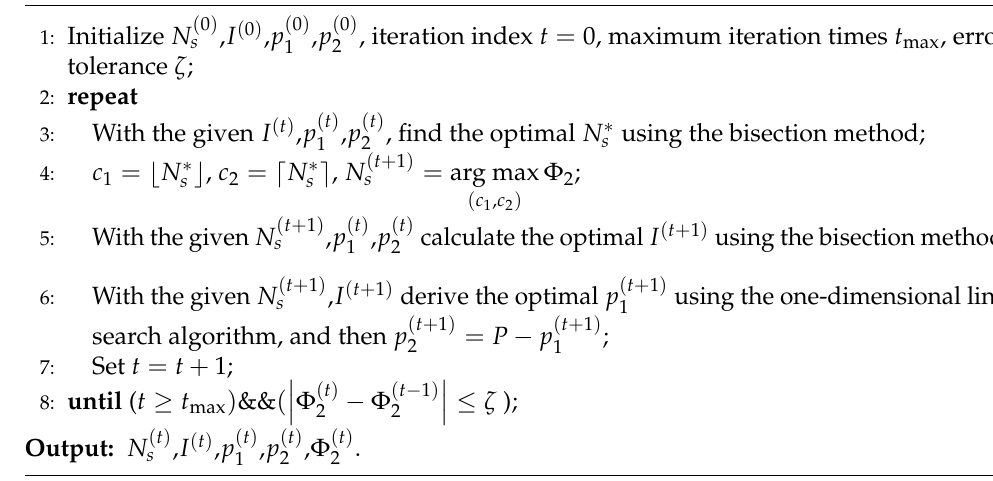
Algorithm 1 Proposed Algorithm for Problem